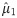
Behavioural modelling.(A) The HGF comprises an observer part, describing the beliefs inferred at 3 levels (low: predictions about target location/latency; middle: cue-target validity level; high: volatility of cue validity), and the response part, linking these beliefs to predicted responses. The full model assumes all 3 levels and a weighted influence of relevant (saturated blue/red) and irrelevant (unsaturated) predictions on participants’ responses. Grey: model states; orange: model parameters. (B) Three alternative observer models (HGF3, HGF2, RW) and 2 alternative response models (task-general: weighted influence of relevant and irrelevant predictions; task-specific: exclusive influence of relevant predictions) were subject to Bayesian model selection. Plot shows log-model evidence relative to the weakest model and indicates task-specific HGF2 as winning. (C) HGF-derived trial-by-trial time-series (representative participant) of predictions about target location/latency (μ^1; upper panels) and cue validity (|μ^2|; middle panels) and PEs about target location/latency (|ε2|; lower panels). (D) Mean correlations between HGF regressors. (E) Correlation between the prior variance of validity level updates and mean accuracy across participants. Data pertaining this figure are available on Figshare https://figshare.com/s/2d2755bfdeea1cbb415f. HGF, Hierarchical Gaussian Filter; HGF2, 2-level HGF; HGF3, 3-level HGF; PE, prediction error; RW, Rescorla-Wagner.